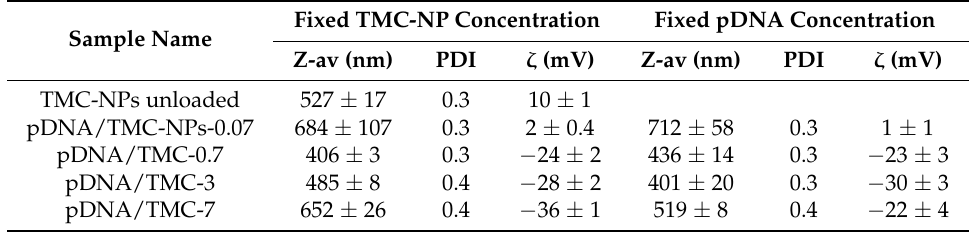
Table 1. Particle size (Z-av), polydispersity index (PDI), zeta potential ( ζ ) and loading efficiency (LE) of trimethyl chitosan (TMC) nanoparticles (NPs) with or without pDNA ( n = 3). pDNA/TMC-NPs were